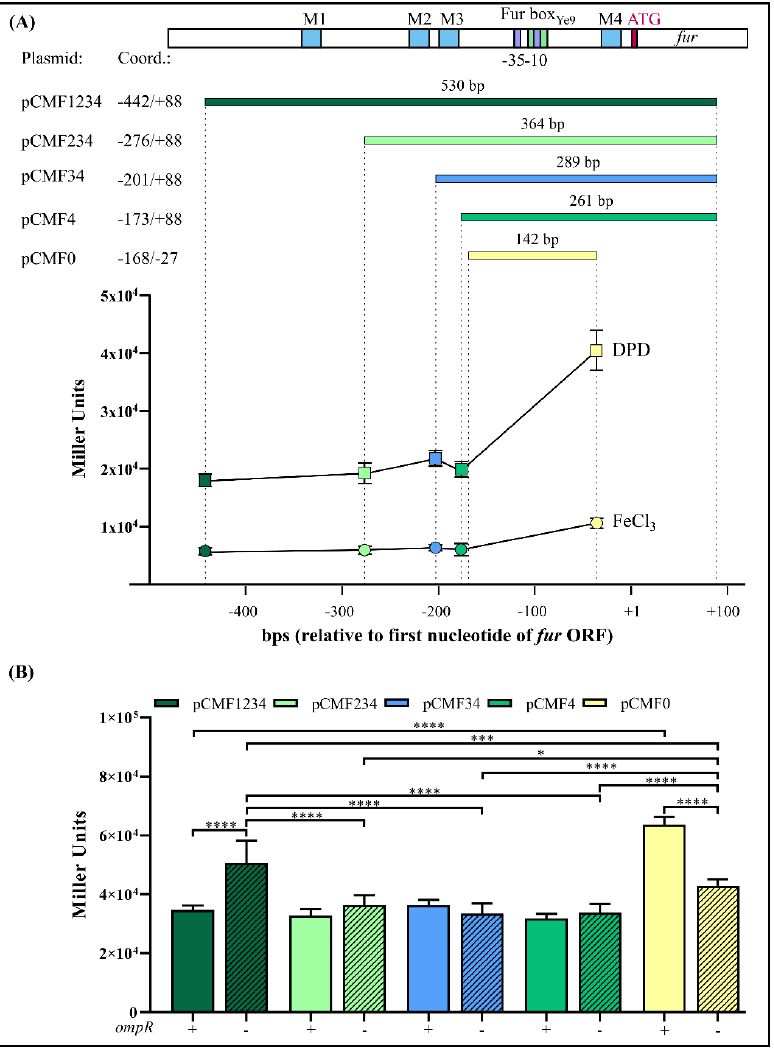
Figure 4. Effect of successive deletion of the Y. enterocolitica Ye9N fur regulatory region on the ex- pression of fur . ( A ) At the top, a schematic presentation of the Y . enterocolitica fur promoter region (YeP fur ) with the location of potential OmpR-binding motifs (M1, M2, M3 and M4) marked. Below this, the different fragments of YeP fur used to construct transcriptional fusions with lacZ in pCM132Gm are shown. The sizes of the fragments are given and coordinates assigned, with +1 cor- responding to the first nucleotide of the fur ATG start codon. At the bottom, the expression of the P fur :: lacZ transcriptional fusions from the following plasmids is plotted: pCMF1234, pCMF234, pCMF34, pCMF4 and pCMF0. β-Galactosidase activity was measured in Ye9N (WT) transformants grown to early stationary phase in LB medium at 26 °C, under iron-limiting (150 µM DPD) or iron- replete (10 µM FeCl 3 ) conditions. Data represent mean activity values with SD from three independ- ent experiments. The obtained differences are statistically significant with p < 0.0001. Significance was calculated using one-way ANOVA. ( B ) Expression of P fur :: lacZ fusions encompassing different fragments of YeP fur in strains Ye9N (WT, + ompR , smooth bars) and AR4 (Δ ompR mutant, − ompR , hatched bars). β-Galactosidase activity was measured in the strains grown to early stationary phase in LB medium at 26 °C. The presented data represent mean β-galactosidase activity values with SD from three independent experiments, each performed using at least triplicate cultures of each strain. Significance was calculated using one-way ANOVA (* p < 0.05, *** p < 0.001, **** p < 0.0001).